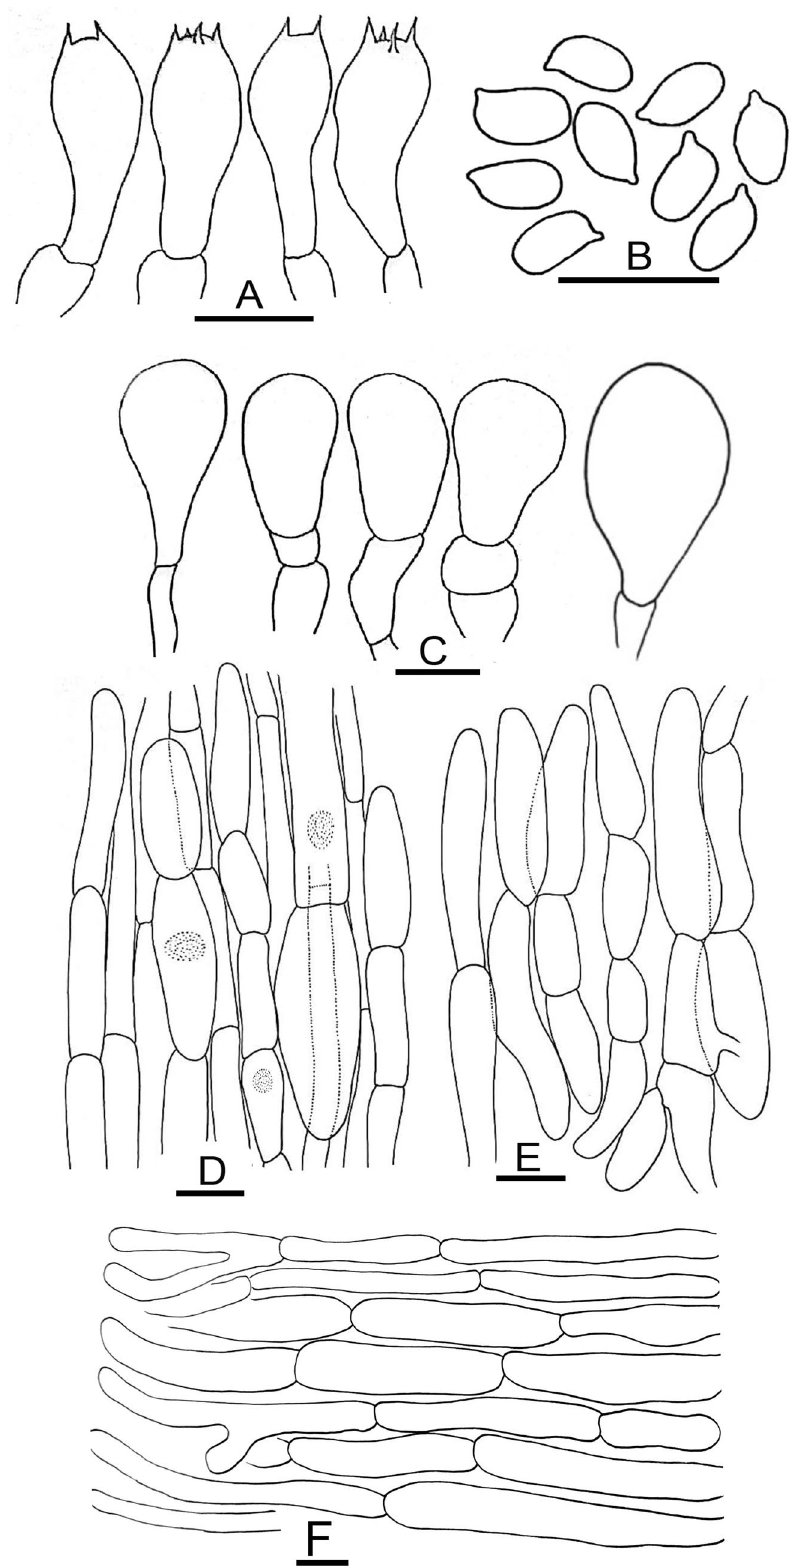
Figure 13. Micromorphological characters of A. macropeplus. (A–F) MW1501 ( Holotype ). (A) Basidia, (B) Basidiospores, (C) Cheilocystidia, (D) Pileipellis hyphae, (E) Stipitipellis hyphae, ( F) Hyphae of the underside of the annulus. Bars = 10 µm. Drawings by Dr. Hira